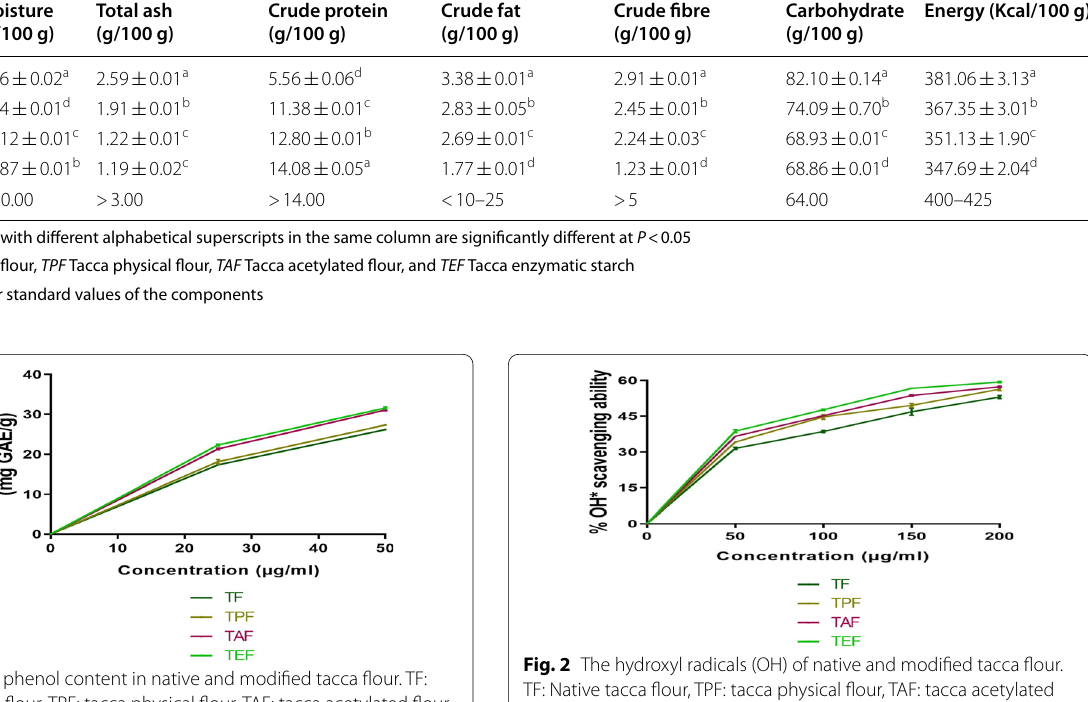
Table 1 Proximate composition and energy of tacca native and modified flour (dry weight basis)